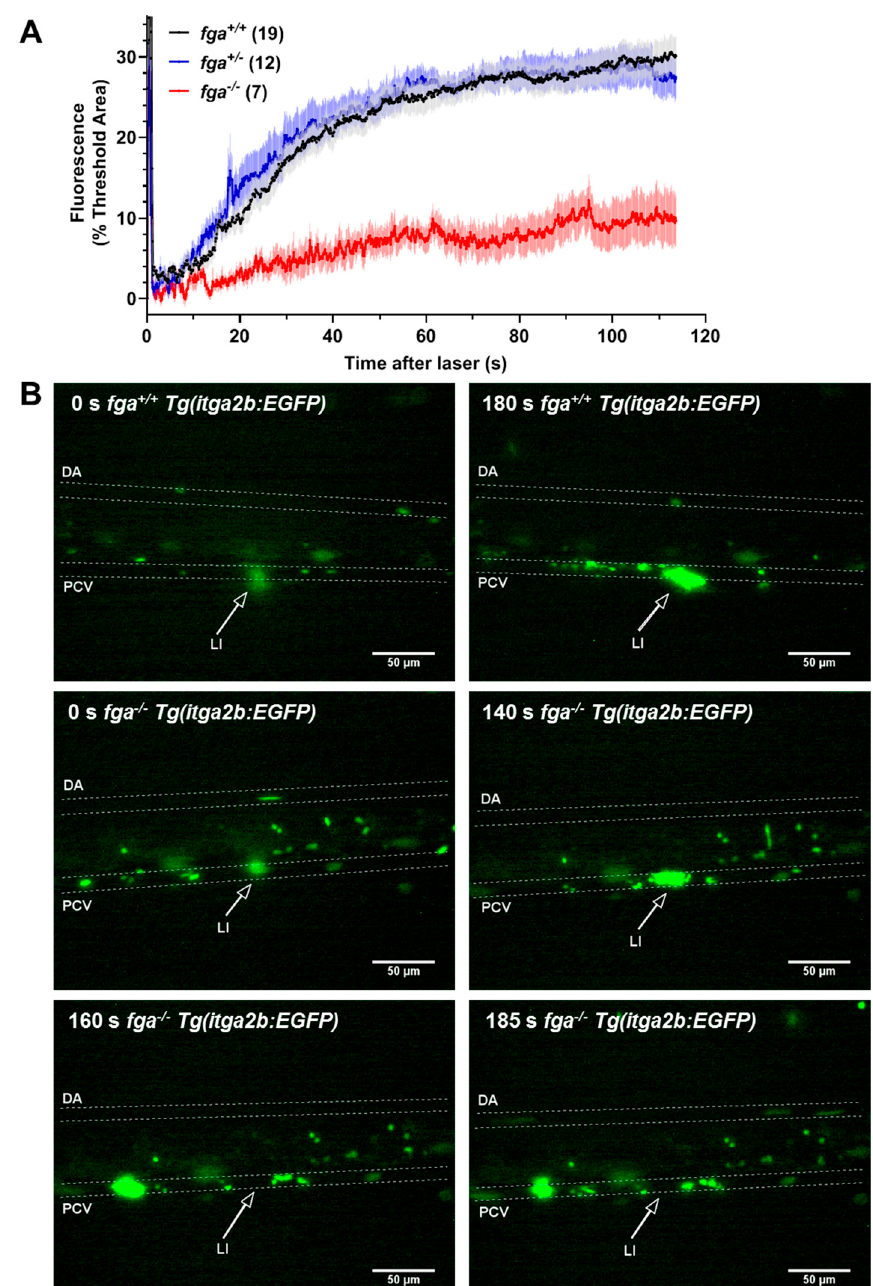
Figure 2. Thrombocyte adhesion and aggregation in afibrinogenemic zebrafish. ( A ) Laser-induced vessel injury to measure thrombocyte binding and accumulation in 5 dpf Tg(itga2b:EGFP) embryos with fluorescent thrombocytes. The thrombocyte-associated green fluorescence accumulation after laser injury within a defined region was measured over time for individual larvae. Each line represents the mean fluorescence (+/ − SEM) for each group. The number of larvae per group is indicated in brackets. ( B ) Images from fga +/+ and fga − / − larvae upon (0 s) and after laser injury, times as indicated. The dorsal aorta (DA), posterior cardinal vein (PCV) and site of laser injury (LI, arrow) are indicated. Green near the laser injury site (arrow head) indicates the laser flash (0 s) and the accumulation of green fluorescent thrombocytes at later time points.